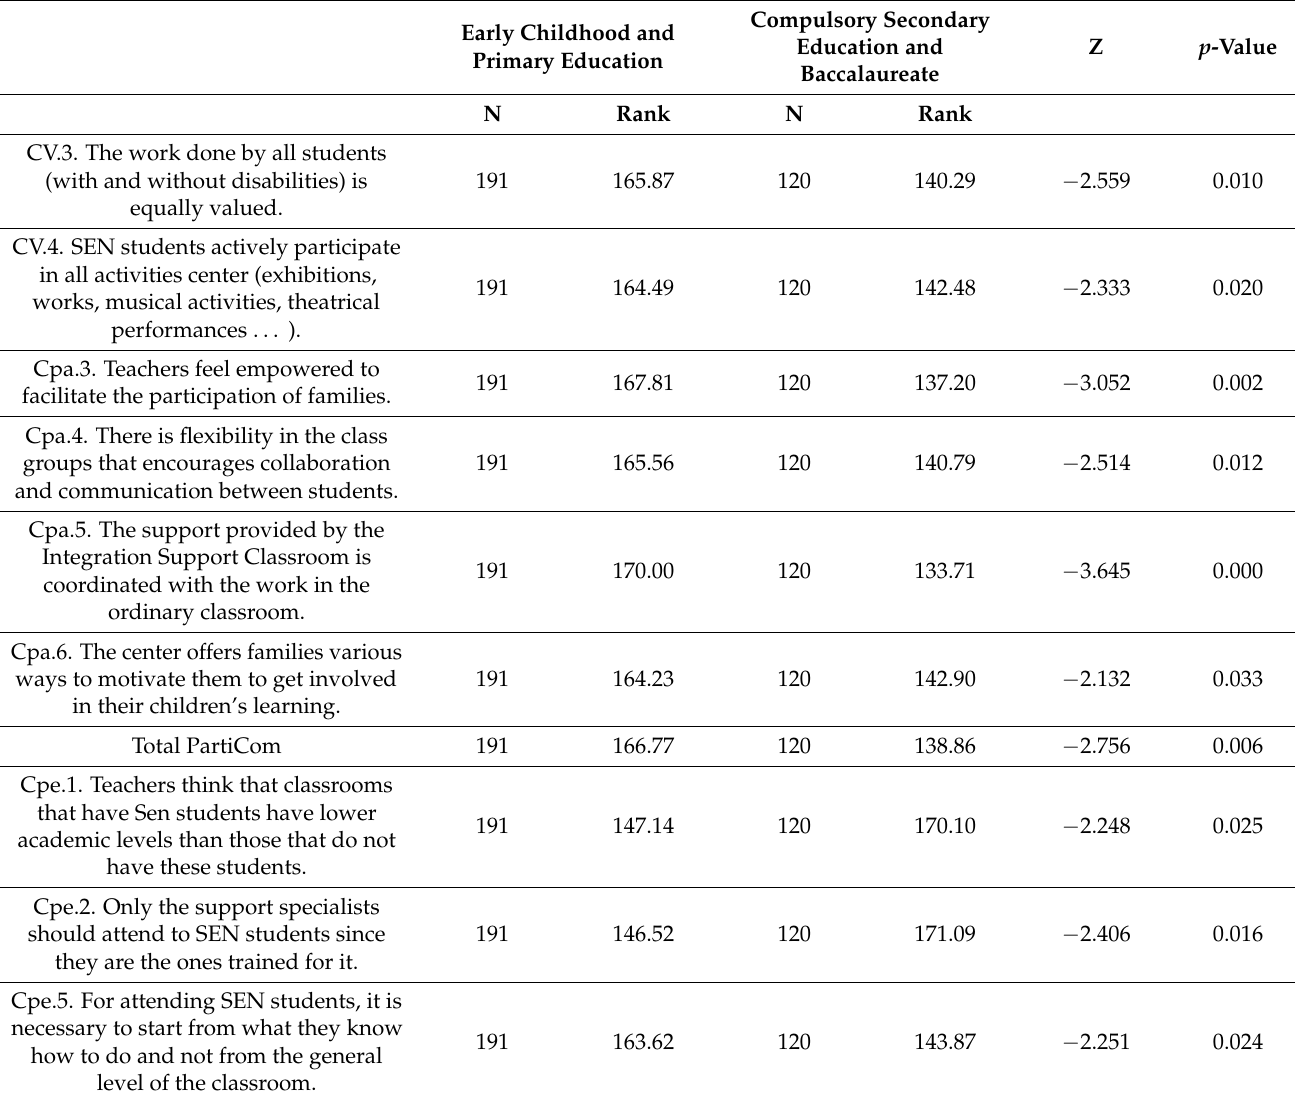
Table 8. Analysis of the Mann Whitney U according to the educational stage of